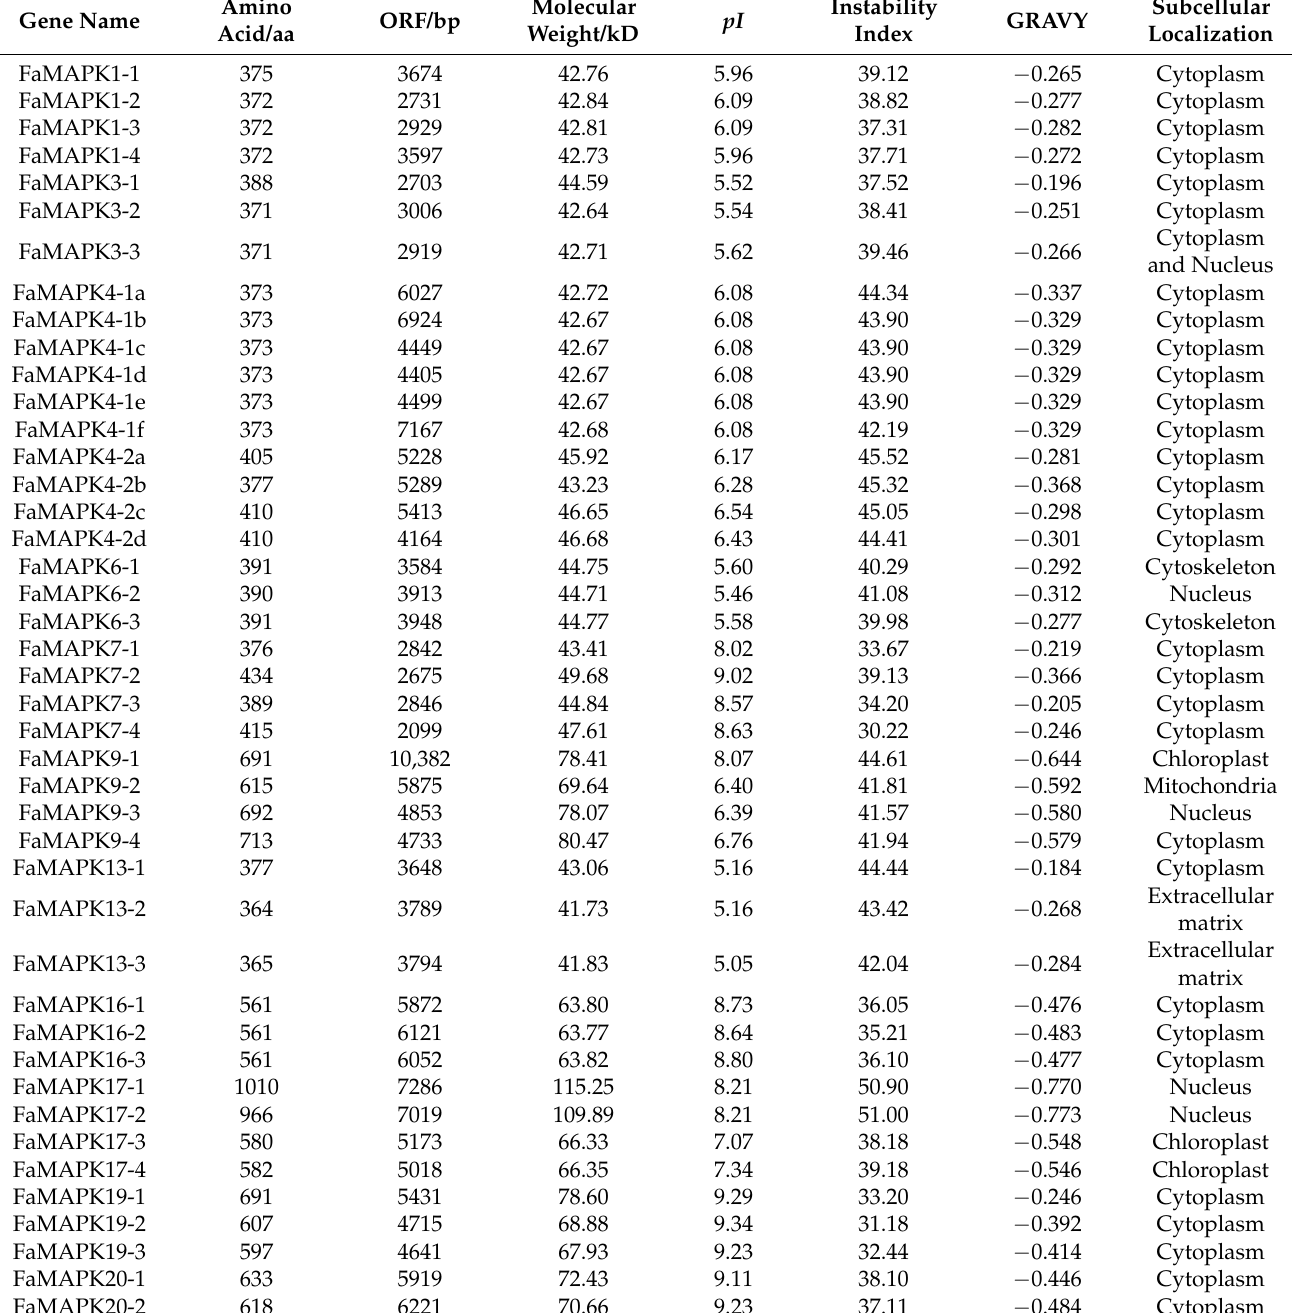
Table 1. Physical and chemical aspects of MAPK genes in the cultivated